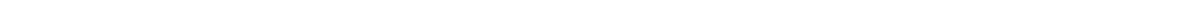
Fig. 7 MANF interacts with PIP4k2b. a Recombinant MANF-His protein was mixed with wild type (WT) mouse brain lysate (MANF/lysate). Two control reactions were set: 1. MANF-His protein only (MANF only); 2. WT mouse brain lysate only (Lysate only). The reactions were incubated at 4 °C overnight, and then Ni-NTA beads were added to pull down MANF-His protein together with its interacting partners. b A single image of silver stain result of His-pull down in Fig. 7a. The band that is speci fi cally present in MANF/lysate is indicated by a black arrow . c Representative western blotting images (from three independent experiments) showed that GST-PIP4k2b was able to precipitate MANF-His. d Co-immunoprecipitation study using PC12 cells transfected with MANF-HA and Myc-PIP4k2b. Representative western blotting images (from three independent experiments) showed that Myc-PIP4k2b was detected in the pull-down lysate. e Co-immunoprecipitation study using MANF transgenic mouse brain lysate. Representative western blotting images (from three independent experiments) showed that PIP4k2b was detected in the pull-down lysate. f Three different GST tagged PIP4k2b fragments ( Δ 1, Δ 2 and Δ 3) were generated as demonstrated in the fi gure. Representative western blotting images (from three independent experiments) showed that fragment Δ 1 was able to precipitate MANF-His. g Representative western blotting images (from three independent experiments) of subcellular fractionation using wild type (WT) and MANF transgenic (TG) mouse brain lysate. Fractions of nucleus (nuc), cytosol (cyto), endoplasmic reticulum (ER) and mitochondria (mito) were indicated by antibodies against LSD1, MEK, PDI and COX IV respectively. h Representative western blotting images (from three independent experiments) of PIP4k2b levels in either total or ER fraction of WT and TG mice. i Quanti fi cation of western blotting results in Fig. 7h (* P < 0.05, n = 3; 2- tailed student t test, Brain, t = 2.99, P = 0.0480; Liver, t = 1.376, P = 0.3026). Data are represented as mean ±